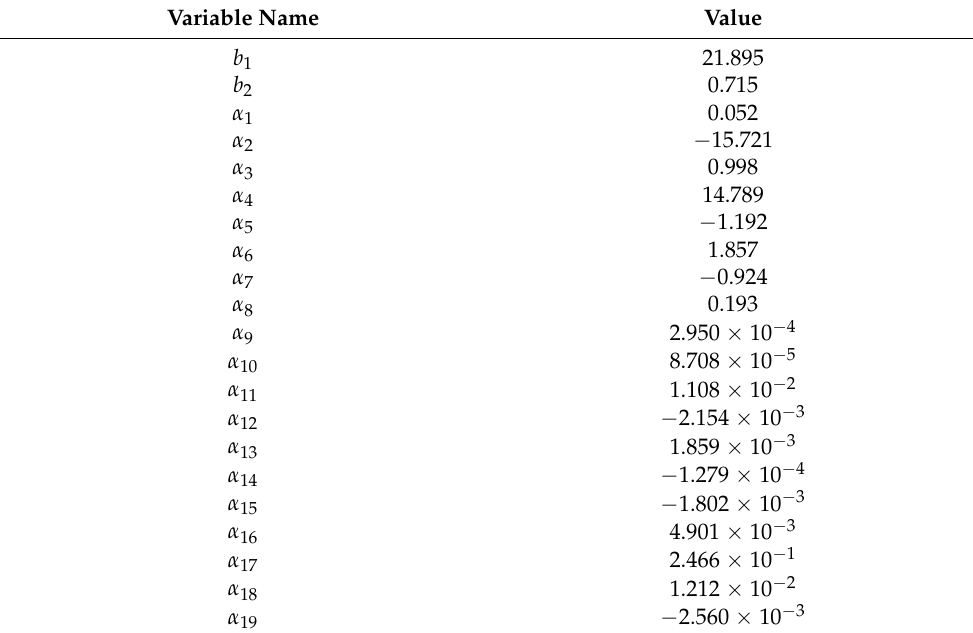
Table 3. The values of the intercept and